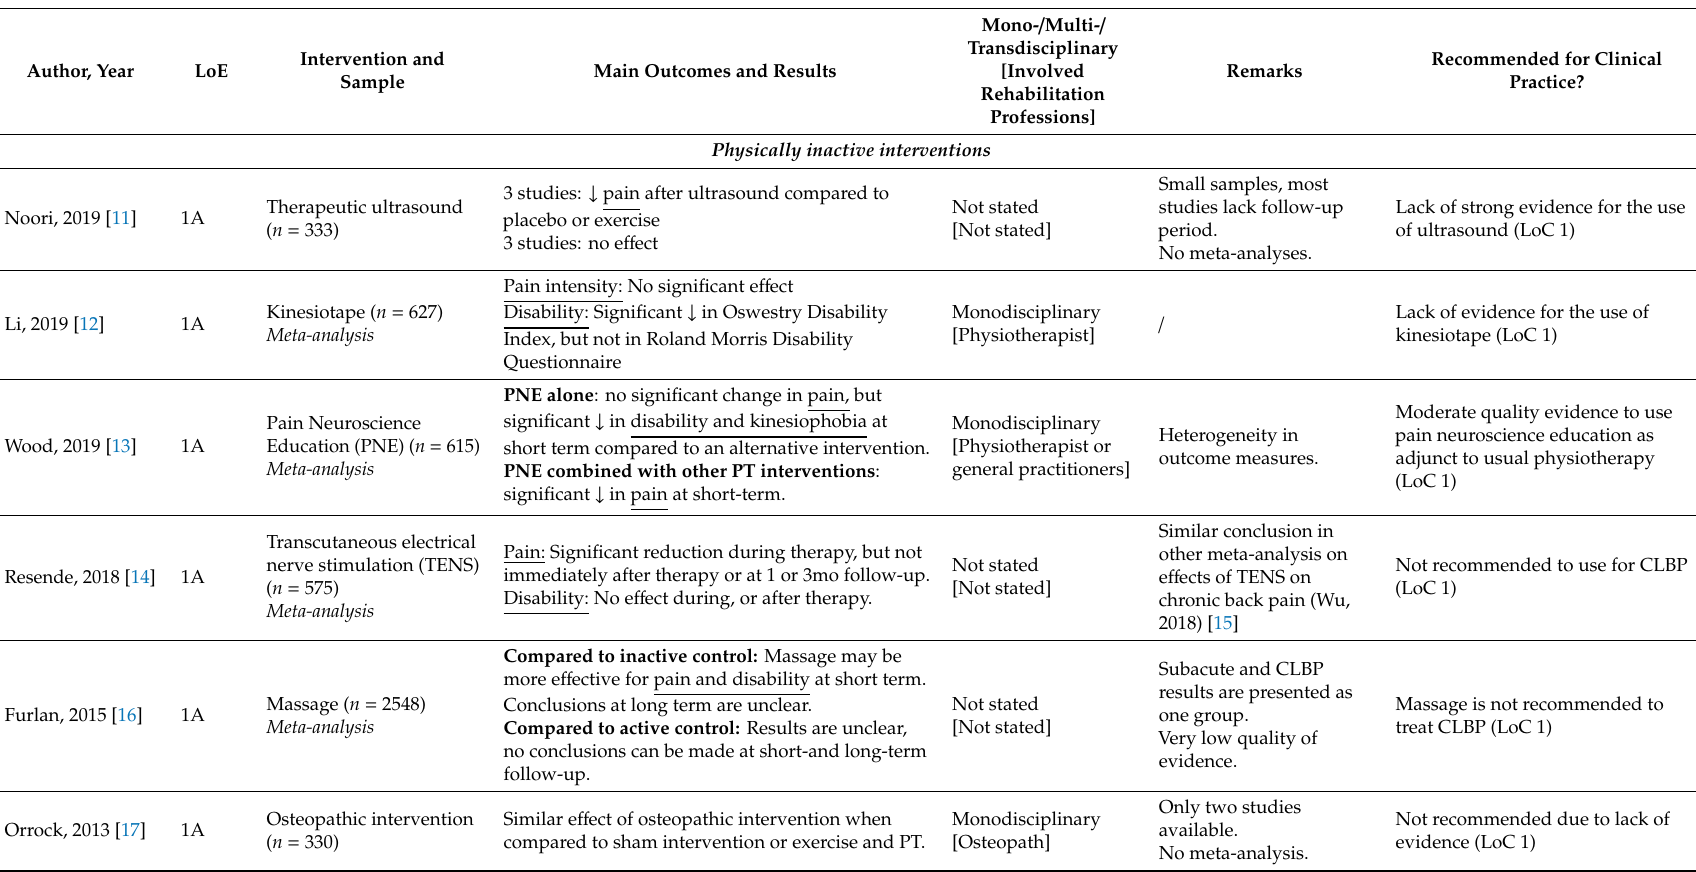
Table 1. Best evidence table for non-invasive rehabilitation in people with chronic low back pain: evidence from systematic reviews and